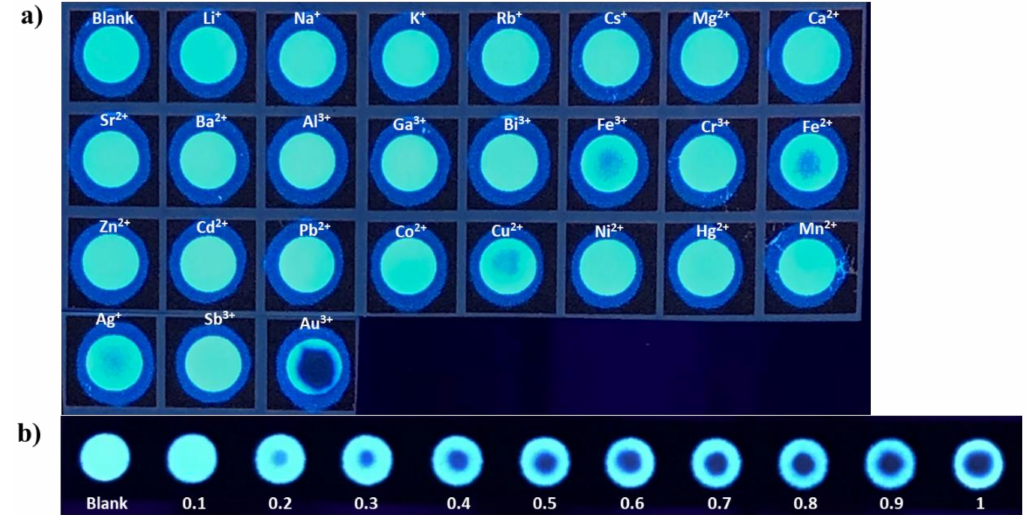
Figure 8. ( a ) Photographic image of various metal ions (5 nmol) detected by DHP-OH (5 nmol) on filter paper under 365 nm UV irradiation for 5 min. ( b ) Photographic image of DHP-OH (5 nmol) in various equivalents of Au 3+ (0–1 nmol).